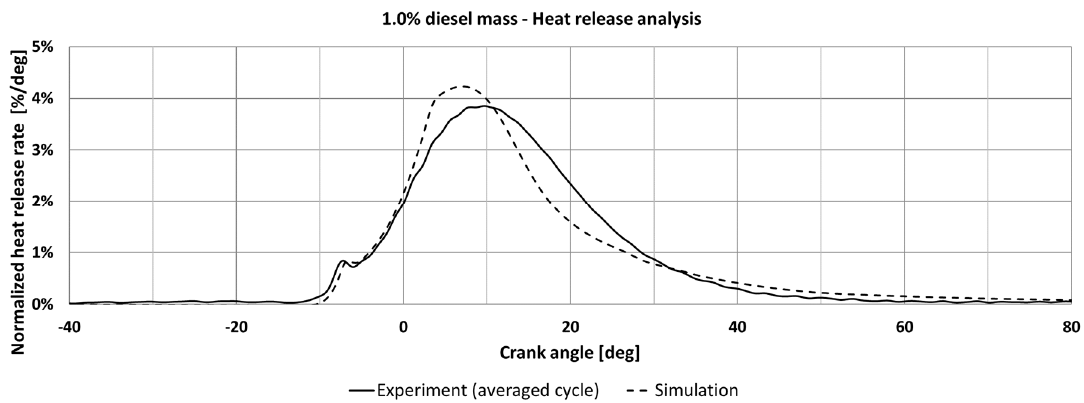
Figure 17. Measured and simulated heat release rates, 1.0% diesel mass injected.